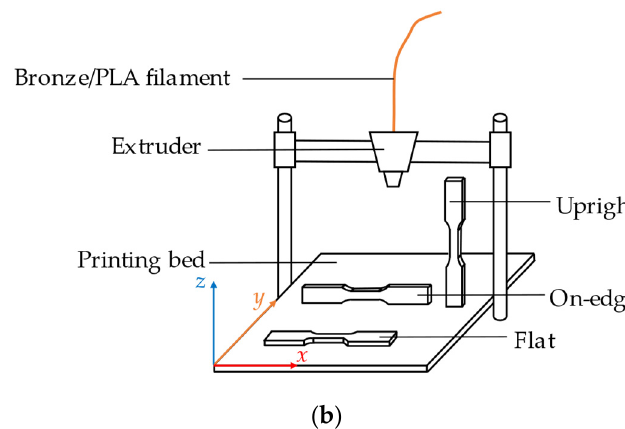
Figure 4. Schematic drawing of the printing process of the investigated specimens: ( a ) actual dimensions of the tensile test sample in (mm); ( b ) printing directions of the tensile simples.